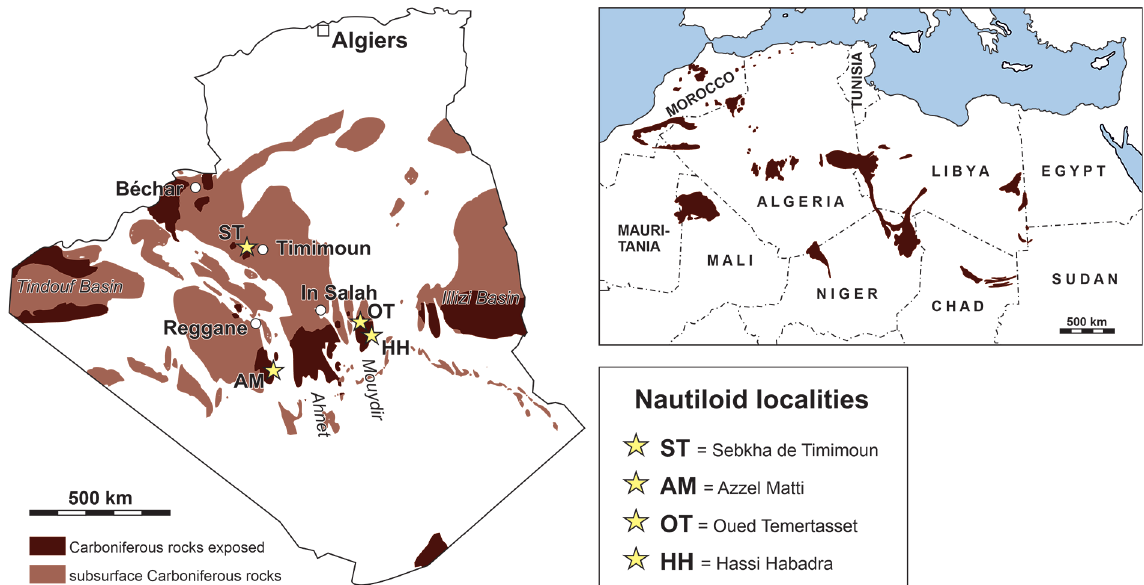
Fig. 1. Geographic position of the fossil sites with the coiled nautiloid specimens described